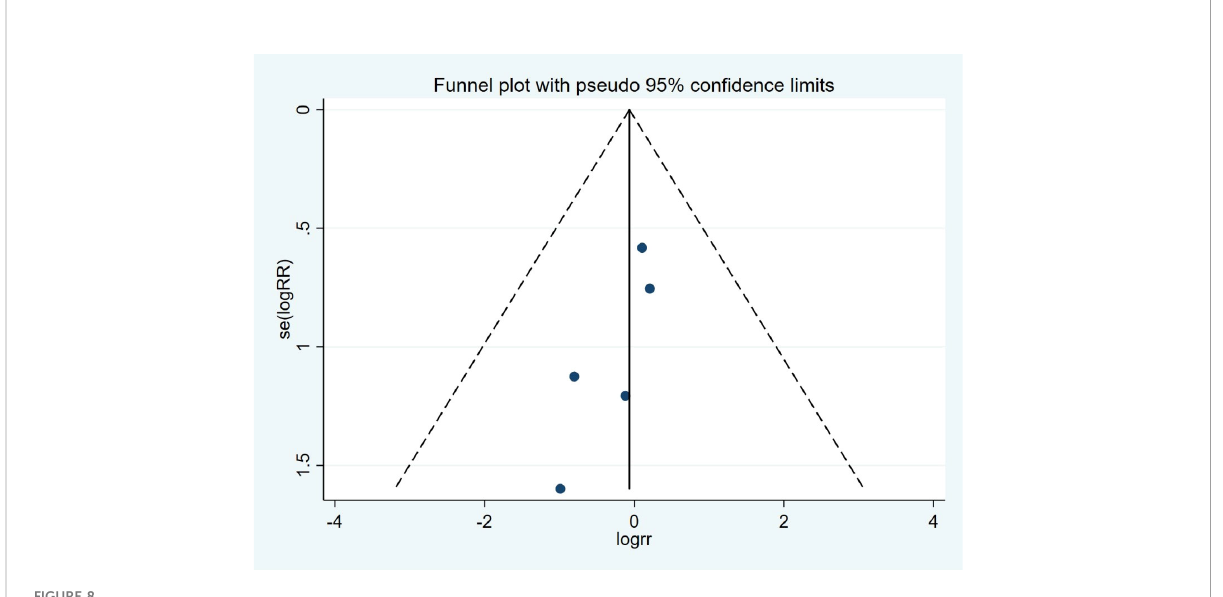
FIGURE 8 Funnel plots for stent